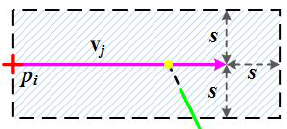
p . The i p . The green v of the LGS of i j v . The j v j